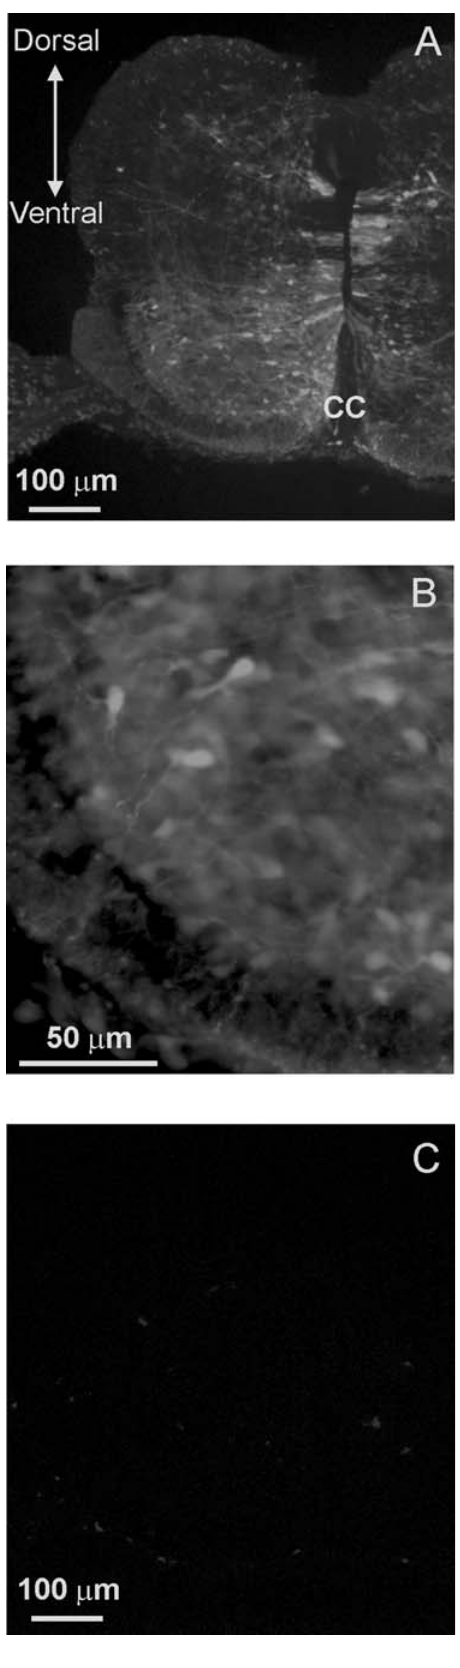
Figure 1. Expression of GFP transgene in the chicken spinal cord following retroviral infection with an RCASBP(B)-GFP construct. RCASBP(B)-GFP viral particles were injected into the developing neural tube at E2 (approximately 36 hr after incubation). A) Infected embryos with RCASBP(B)-GFP show strong fluorescent labeling throughout the whole spinal cord cross section. B) High magnification picture of the ventral spinal cord section shown in A. C) Embryos injected with RCASBP(B) open vector show no fluorescent signal. In these experiments, chicken embryos were infected with RCASBP(B)-GFP or RCASBP(B) open vector at E2. Embryos were allowed to develop until E8 (corresponding to stage 34) before tissue isolation and